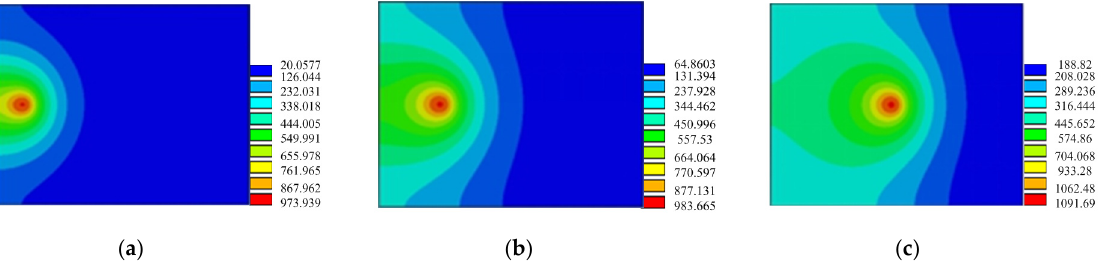
Figure 7. Temperature contour of the plane without cracks in the heating process (0 < t < 40 s). ( a ) t = 5 s; ( b ) t = 10 s; ( c ) t = 18